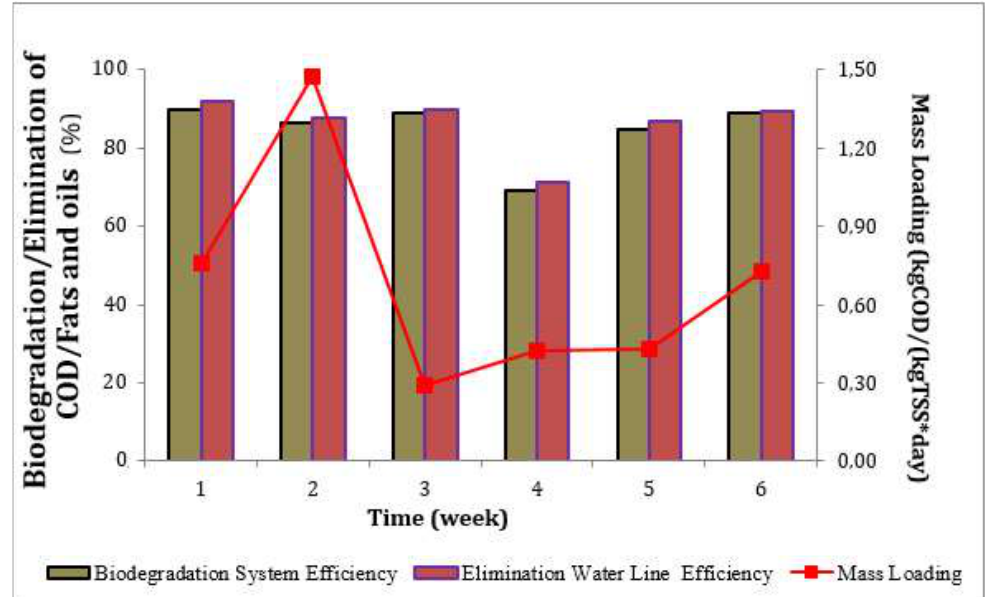
Figure 8. The efficiency of biodegradation and elimination of COD/fats and oils as a function of the Figure 8. The e ffi ciency of biodegradation and elimination of COD / fats and oils as a function of the mass loading in a WWTP-LA. mass loading in a